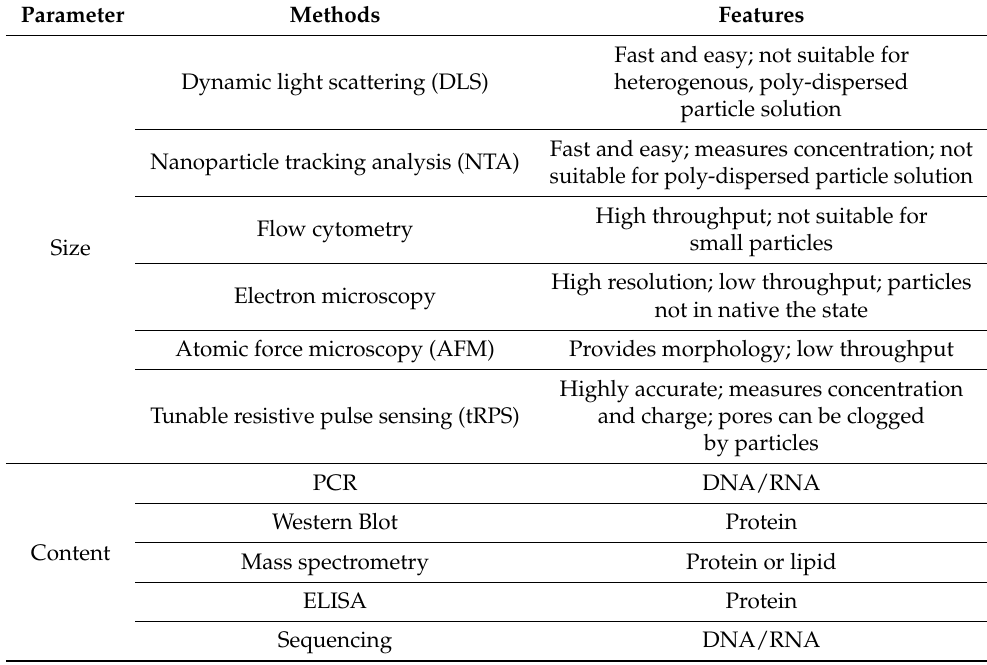
Table 1. Main characterization methods of